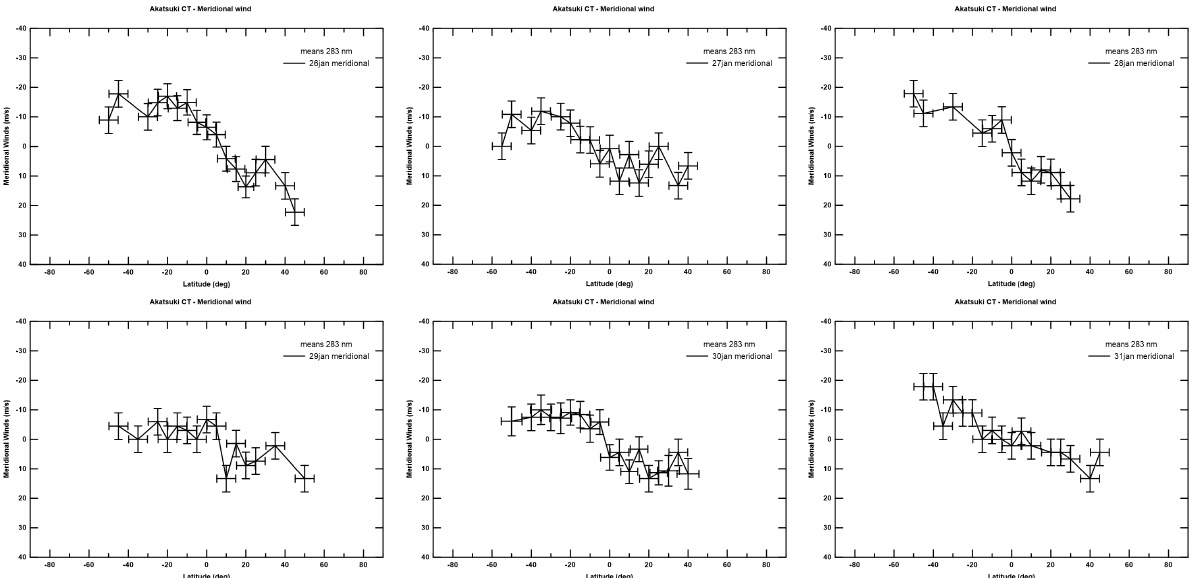
Figure 3. Daily meridional wind latitudinal profiles from the Akatsuki/UVI 283 nm filter observations (26–31 January 2017). After grouping the meridional wind measurements into a binning of 5 ◦ in latitude, we performed a weighted average at each latitude band. Positive velocities mean a motion towards north and negative ones towards south.